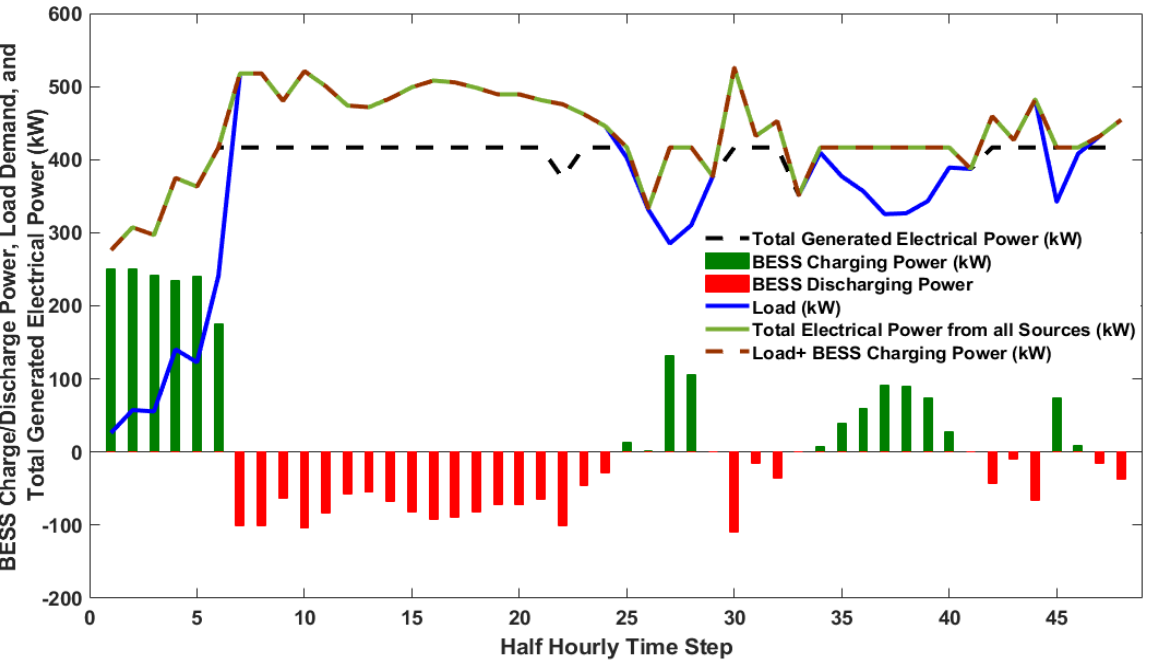
Figure 9. Total electrical power generated, the ideal real-time load demand, and BESS charge/dis- charge command (scenario 1).